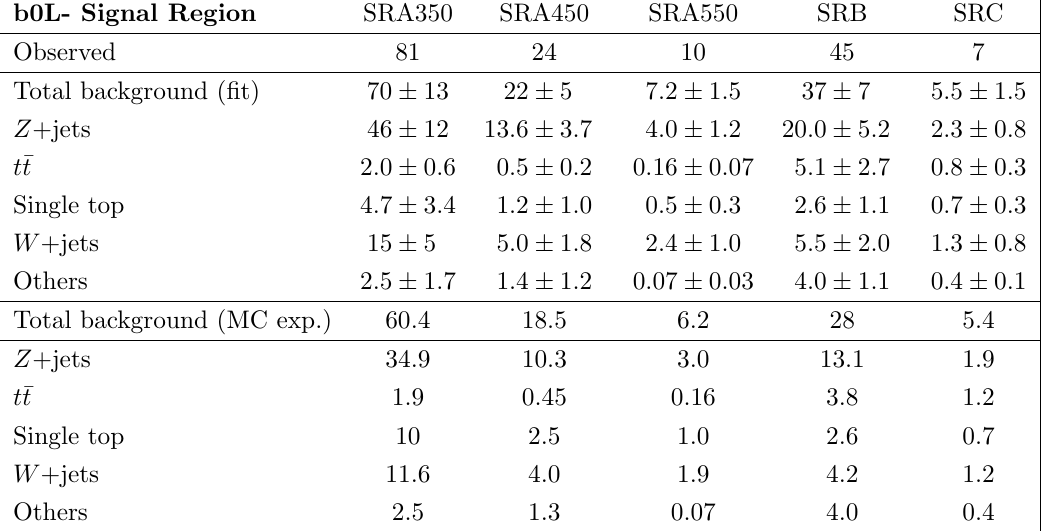
Table 8. Fit results in the b0L signal regions. The background normalization parameters are obtained from the (cid:12)t in the control regions and are applied to the SRs. Smaller backgrounds such as diboson, ttV , multijet and rare processes are indicated as \Others". The individual uncertainties, including statistical, detector-related and theoretical systematic components, are symmetrized and can be correlated. They do not necessarily add in quadrature to the total systematic